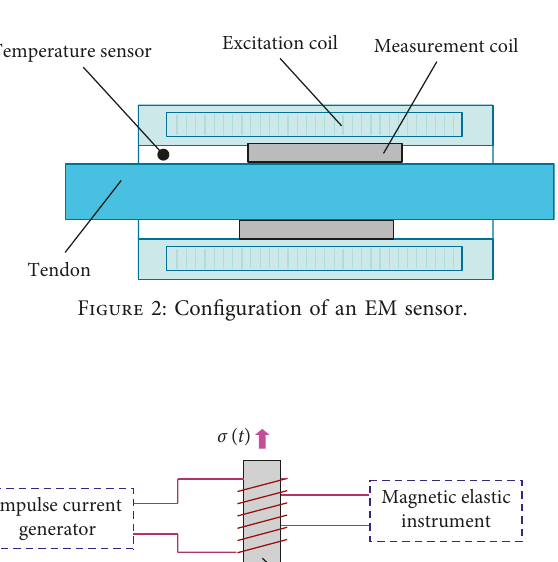
Figure 1: EM sensors used for the stress monitoring of external cables. (a) For stayed cables. (b) For suspenders. (c) For external tendons.